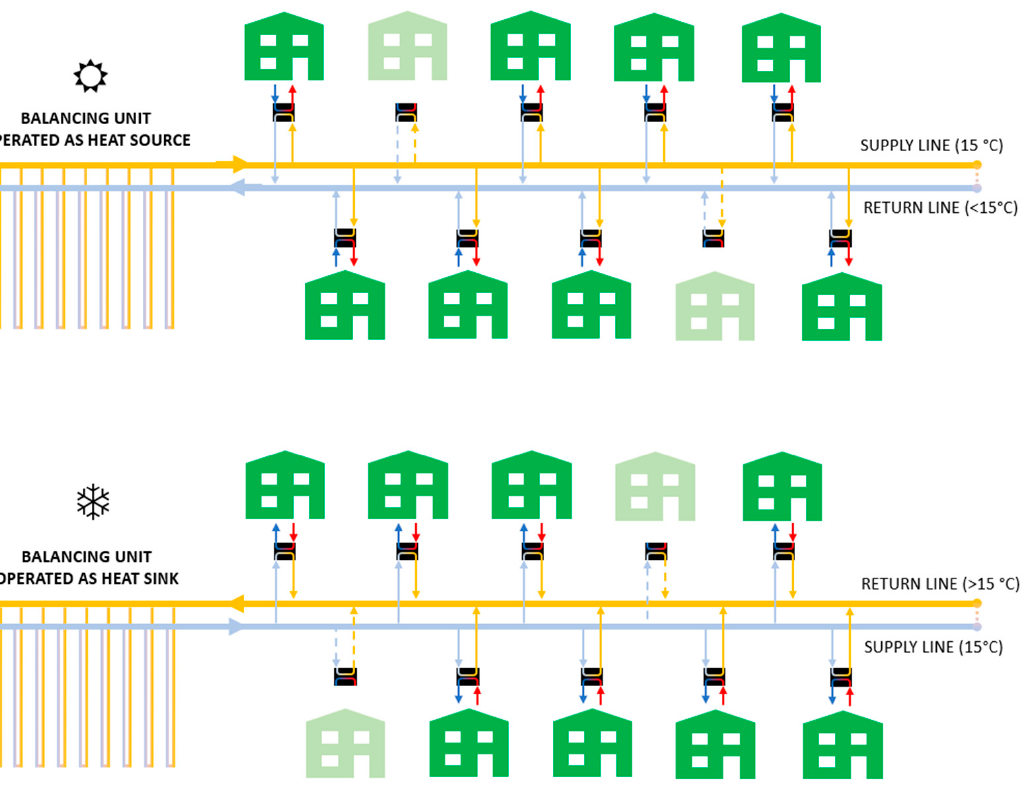
Figure 4. Illustrative scheme of a small 5GDHC network. Several residential units with individual- 525 ized GSHPs and similar demand profiles (not necessarily simultaneous) share a vertical BHE field 526 (BU), as a heat source ( above ) or as a heat sink ( below ).